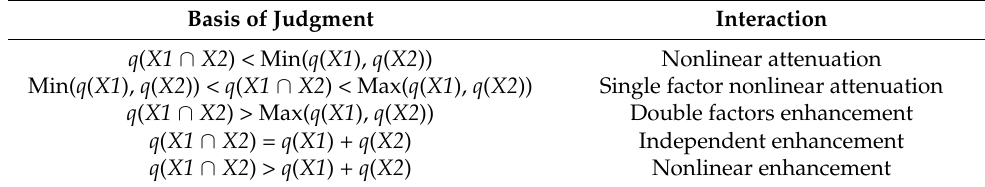
Table 1. Types of interaction between two